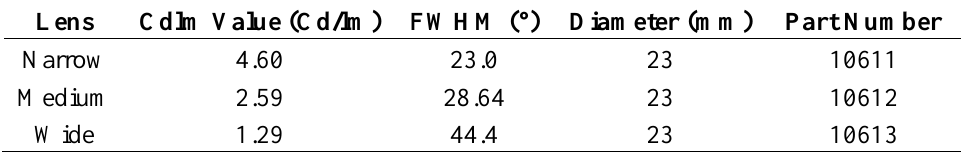
Table 3. Lens specifications used for simulation (Carclo Optics, Ayesbury,